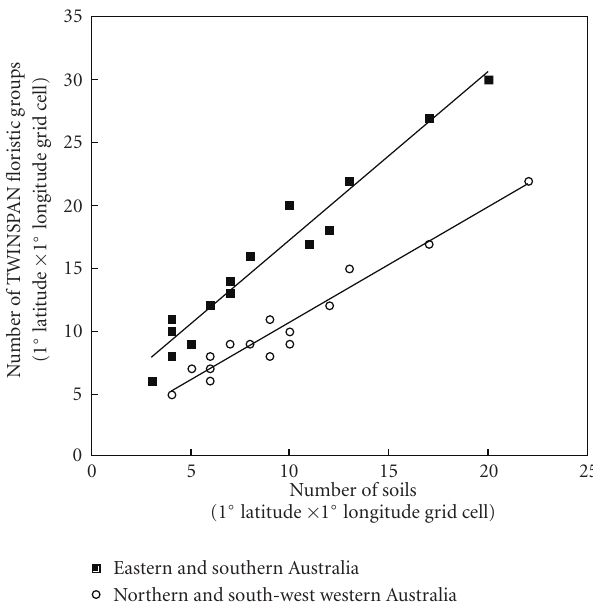
Figure 2: Number of TWINSPAN Floristic Groups (per 1 ◦ latitude × 1 ◦ longitude grid cell), plotted against the number of Soil Groups recorded in the same grid cells in south-eastern and Western Australia [19, 20]. South-eastern Australia Floristic Groups = 1.34 Soil Groups + 3.83 ( n = 15; r 2 = 0 . 96). Western Australia Floristic Groups = 0.92 Soil Groups + 1.51 ( n = 15; r 2 = 0 .